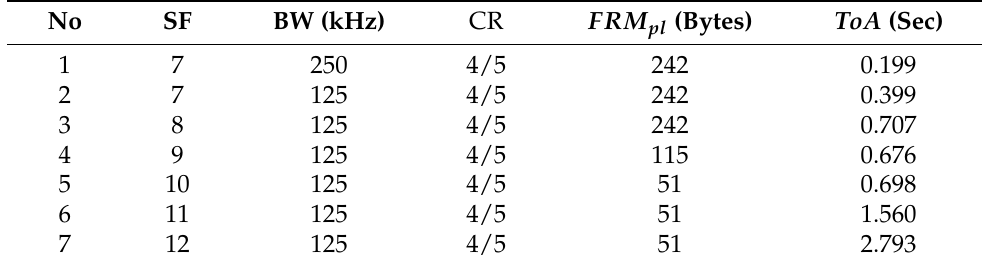
Table 2. Transmission options in EU(863-870MHz)